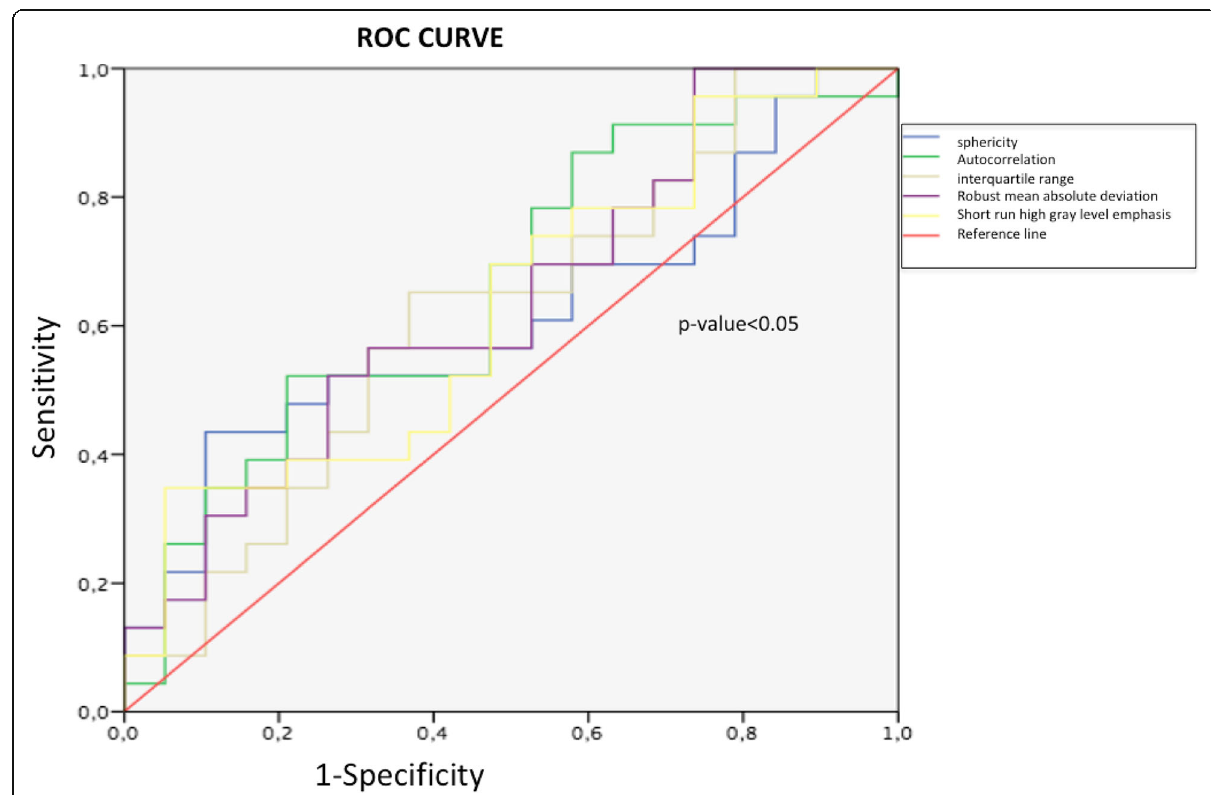
Fig. 2 Receiver operating characteristic curve of feature parameters differetiating between low and high Ki-67 expression on digtal breast tomosynthesis. Features were included if the area under the curve was > 0.6 in association with statistical significance